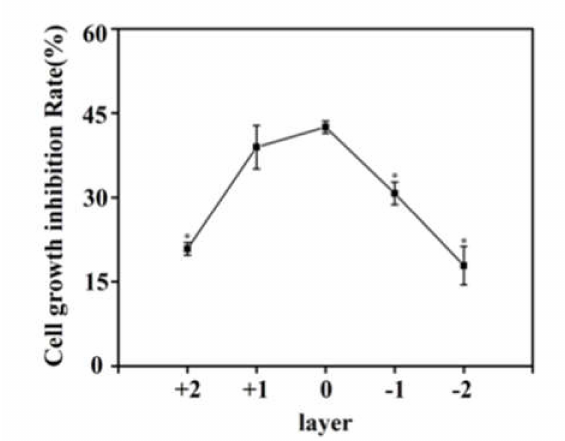
Figure 6. DU145 cells were seeded in layer 0 and the assembled multi-layer migration stack was cultured for seven days. Then each paper sheets were separately placed into culture medium containing 0.5 µ M doxorubicin for 48 h. Finally, an MTT assay was conducted with doxorubicin-treated paper sheets. Cell growth inhibition on each paper layer was calculated using non-drug treated cells as reference samples (e.g., growth inhibition on L0 was calculated by: [(A570 of L0 without drug treatment − A570 of L0 with drug treatment)/A570 of L0 without drug treatment] × 100%. Growth inhibition on L+1, L-1, L+2, and L-2 were calculated, respectively. Error bars represent the standard deviation for 24 replicate zones, * denotes p <